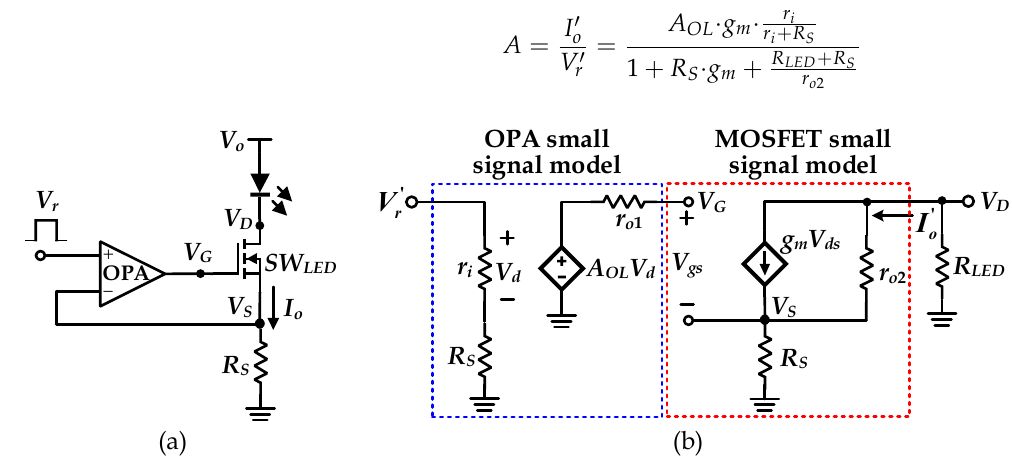
Figure 4. Linear current control circuit: ( a ) Basic topology; ( b ) Equivalent circuit model of ( a ).